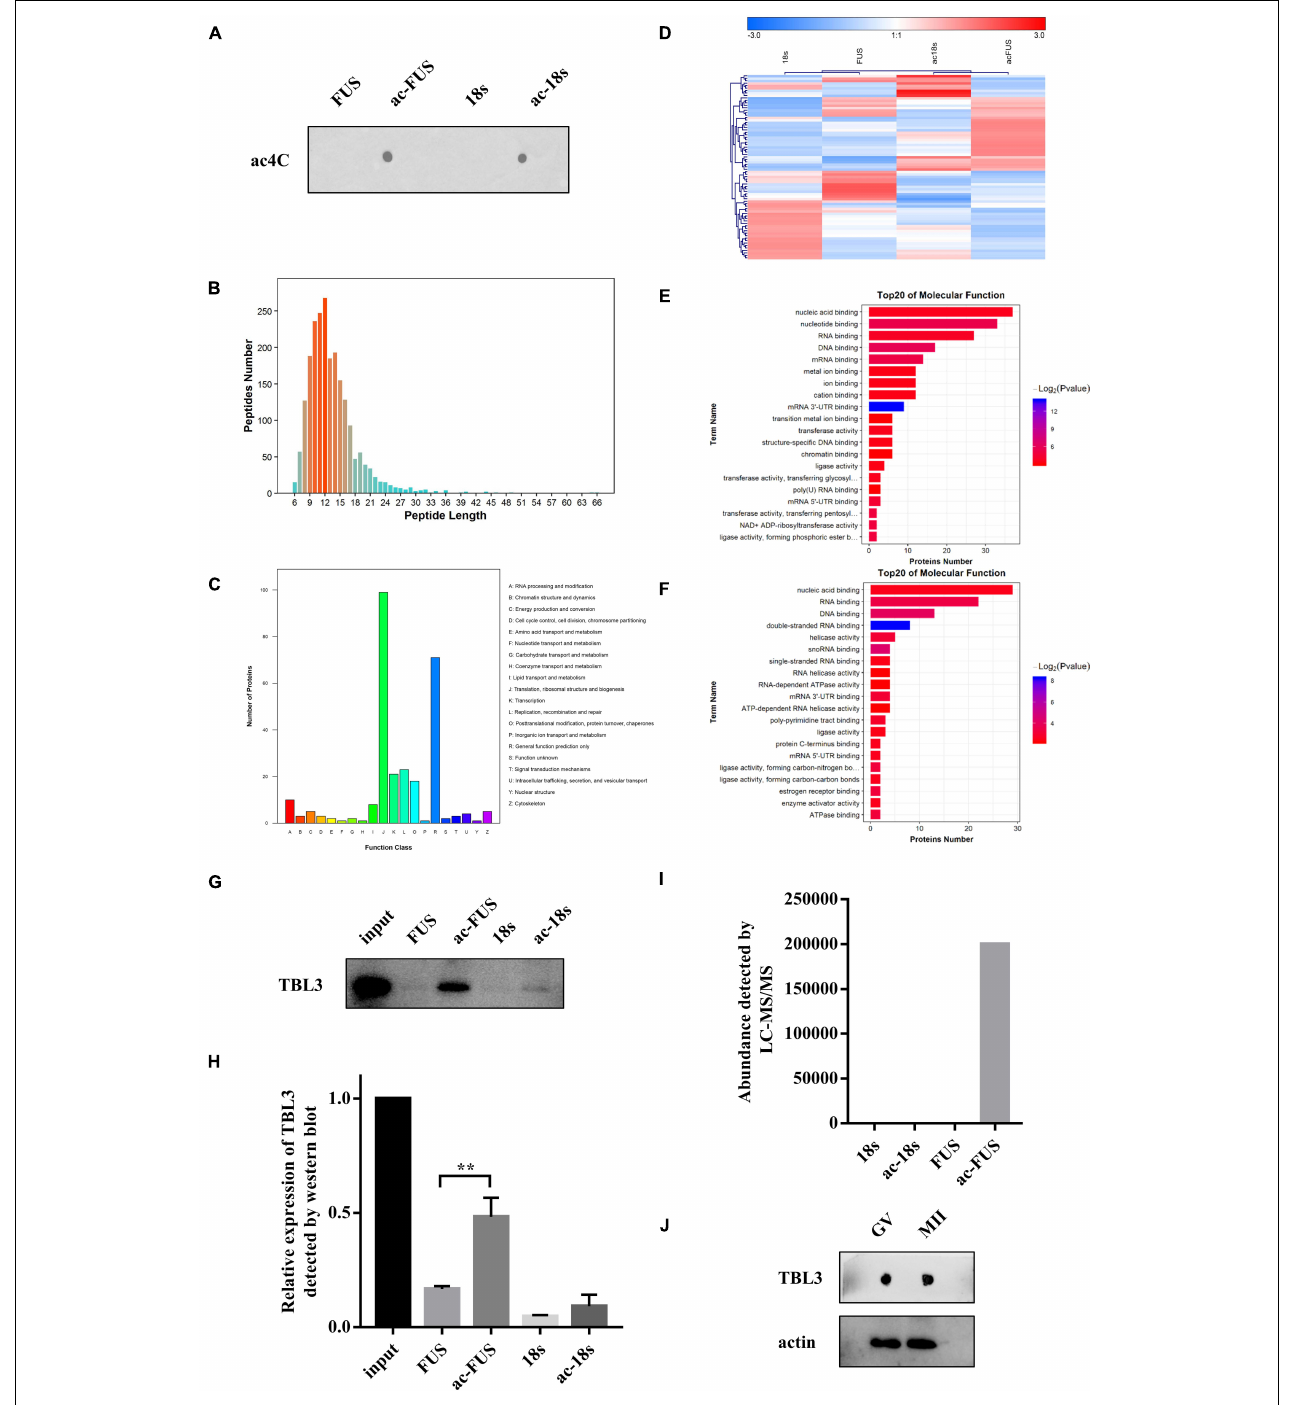
FIGURE 5 | Identification of potential ac4C-binding proteins using HEK293T cells. (A) ac4C dot blot of synthesized acetylated and non-acetylated RNA probes. (B) Distribution of peptide length identified by LC-MS/MS. (C) Functional classification of identified proteins according to COG classification. (D) Hierarchical clustering of differentially expressed proteins. (E) GO enrichment of molecular function, FUS vs. ac-FUS. (F) GO enrichment of molecular function, 18s vs. ac-18s. (G,H) Expression of TBL3 in input and RNA pulldown samples. The data are presented as the mean ± SD from three independent experiments. **Significant difference at p < 0.01. (I) TBL3 abundance identified by mass spectrometry analysis. (J) Immunoblot of TBL3 in mouse oocytes. LC-MS/MS, liquid chromatography-mass spectroscopy/mass spectroscopy. COG, Cluster of Orthologous Groups of proteins. GO, Gene Ontology. FUS, synthetic RNA probe consisting of the acetylated fragment of FUS gene. ac-FUS, ac4C-modified FUS probe. 18s, synthetic RNA probe consisting of the acetylated fragment of 18s rRNA. ac-18s, ac4C-modified 18s probe. GV, germinal vesicle. MII, metaphase II.